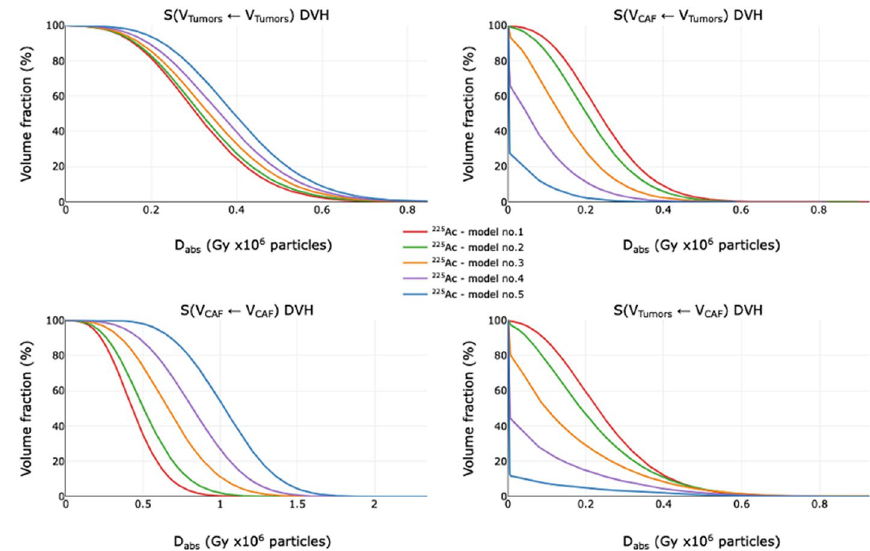
Fig. 7 225 Ac Dose Volume Histograms of the five models for S(v Tumors S(v Tumors v CAF ) and S(v CAF ←